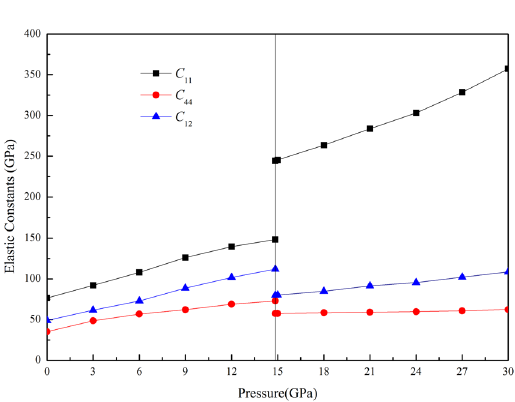
Figure 2. Elastic constants as a function of pressure for both B3 and B1 phases of